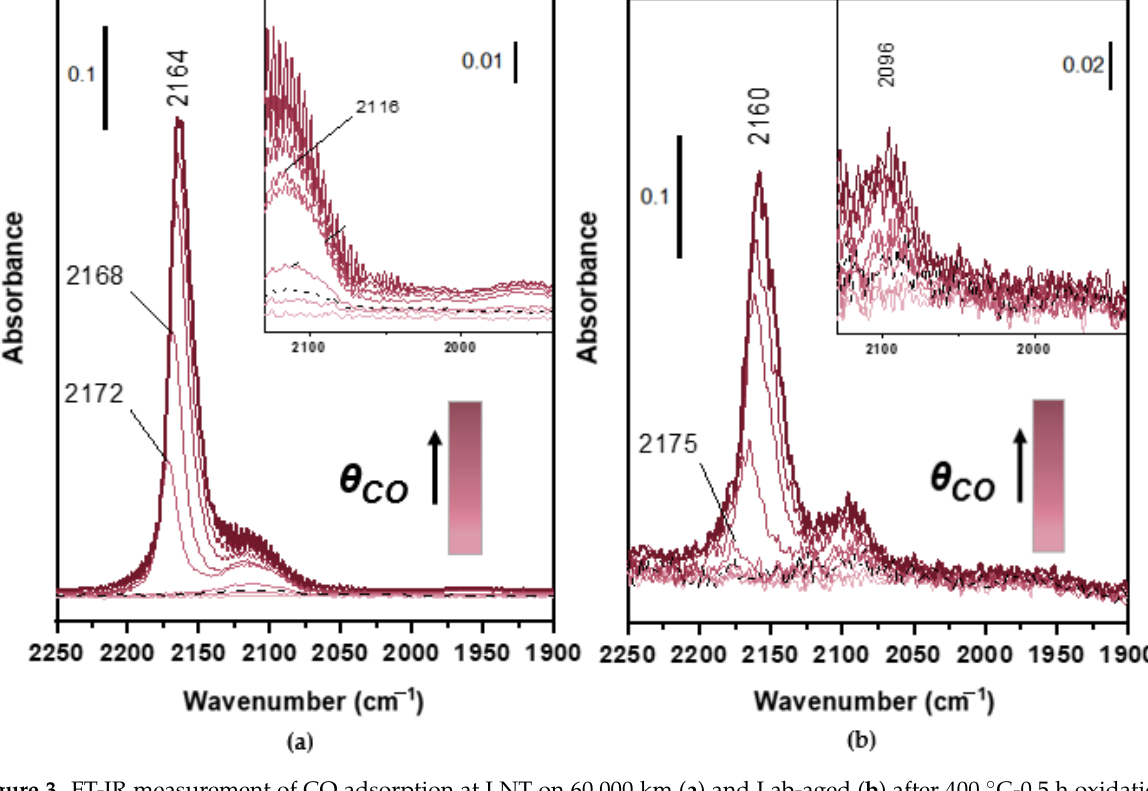
Figure 3. FT-IR measurement of CO adsorption at LNT on 60,000 km ( a ) and Lab-aged ( b ) after 400 °C-0.5 h oxidation- reduction (O 2 -H 2 ) pretreatment at increasing pressure of CO up to 20 mbar and after final outgassing at LNT (black dotted line).